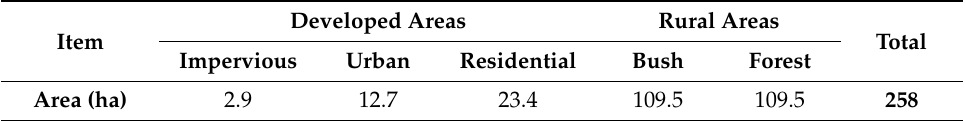
Table 1. Gordo creek watershed’s soil cover distribution.